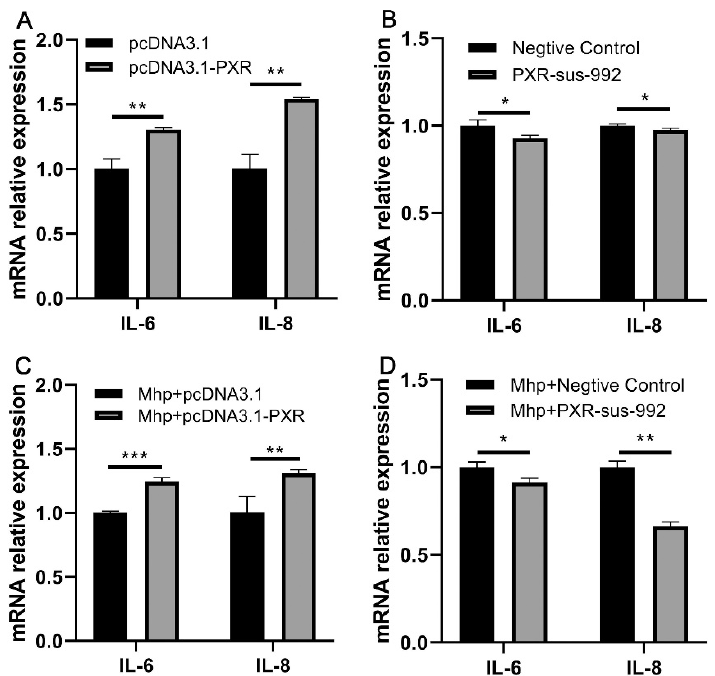
Figure 6. Effects of PXR overexpression and silencing on IL-6 and IL-8 expression in M. hyopneu- moniae -infected PAM 3D4/21 cells. ( A ) The mRNA expression levels of IL-6 and IL-8 after PXR overexpression. ( B ) The mRNA expression levels of IL-6 and IL-8 after PXR silencing. ( C ) The mRNA expression levels of IL-6 and IL-8 after PXR overexpression with M. hyopneumoniae infection. ( D ) The mRNA expression levels of IL-6 and IL-8 after PXR silencing with M. hyopneumoniae infection. The data are presented as the mean ± SD. The experiment was repeated three independent times. * p < 0.05; ** p < 0.01; *** p < 0.001.